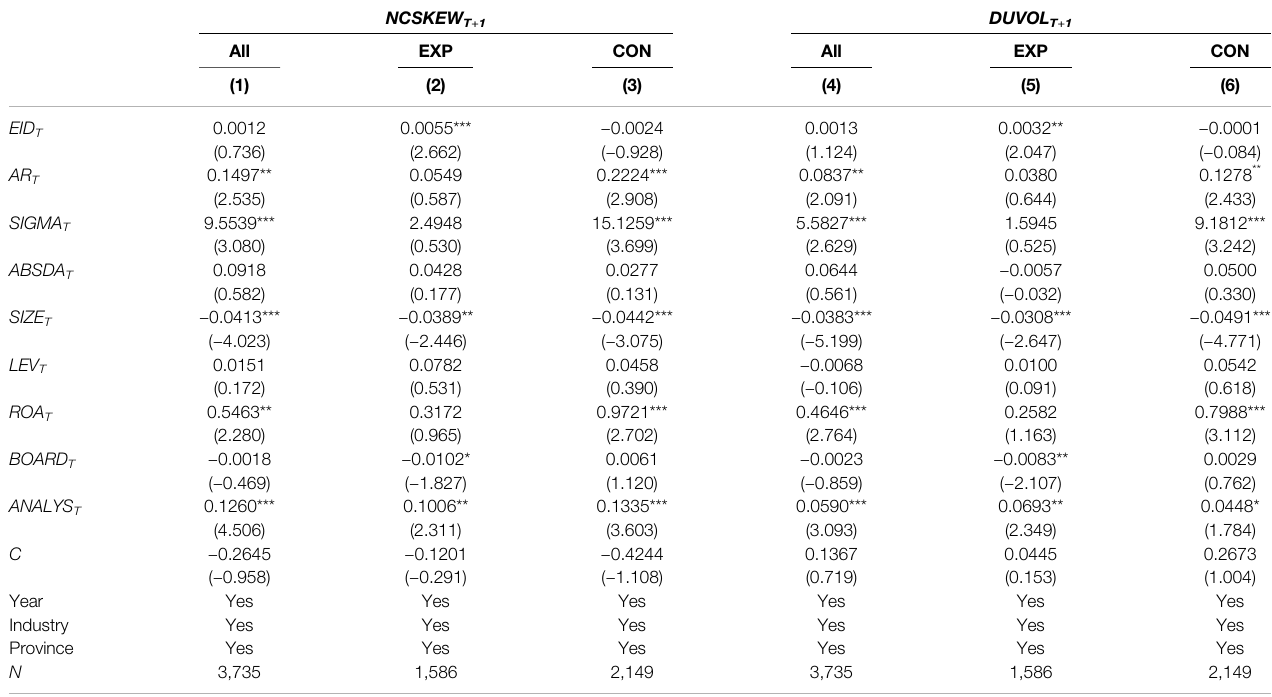
TABLE 7 | Robustness test of the PSM